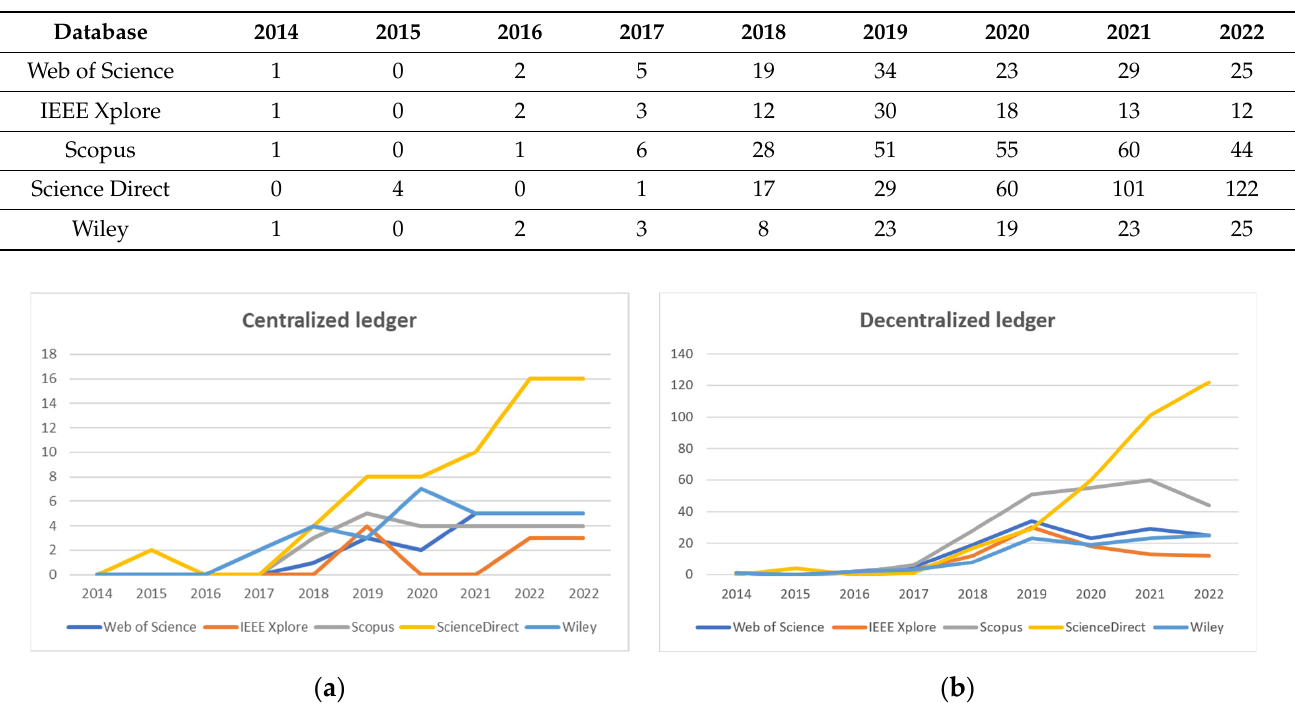
Table 4. Each database’s annual number of papers with “decentralized/decentralized ledgers” keywords.